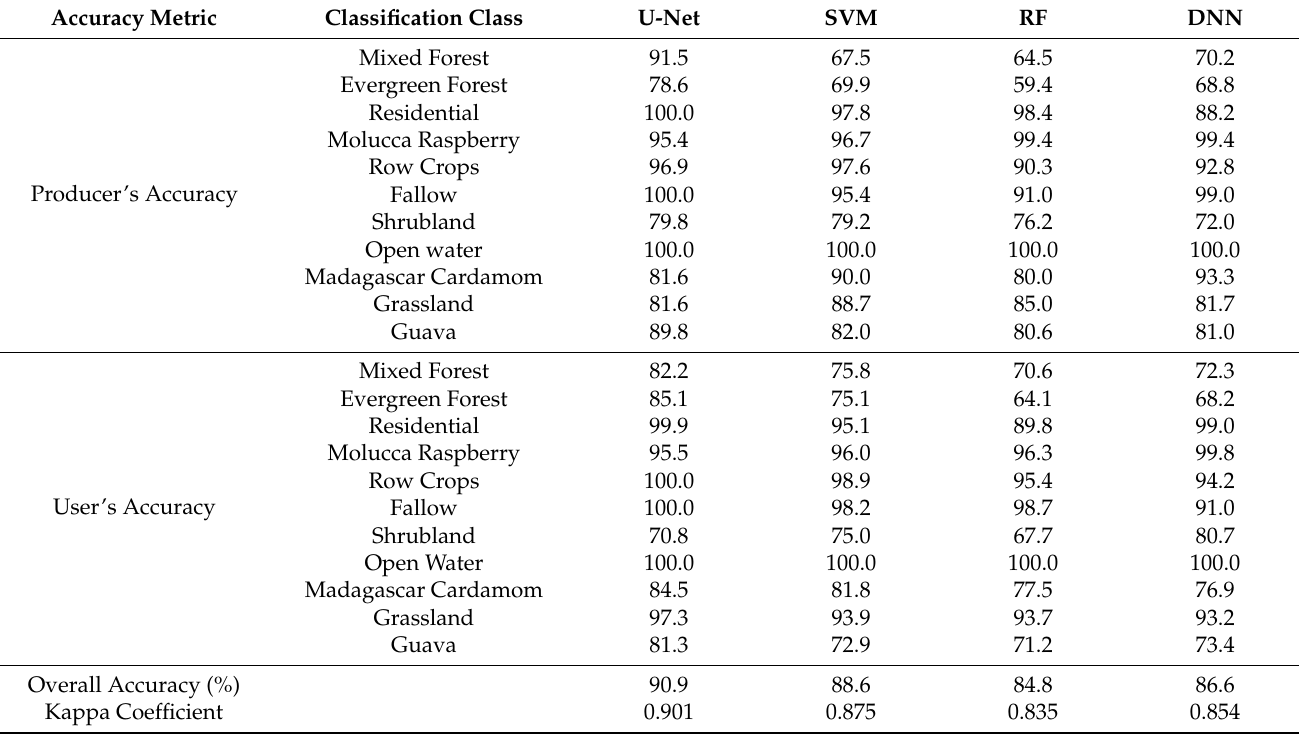
Table 2. Results—overall accuracy (Equation (2)), kappa coefficient (Equation (3)), producer’s (Equation (4)), and user’s accuracy (Equation (5)) for Support Vector Machine (SVM), Random Forest (RF), Deep Neural Network (DNN), and U-Net models, based on independent testing